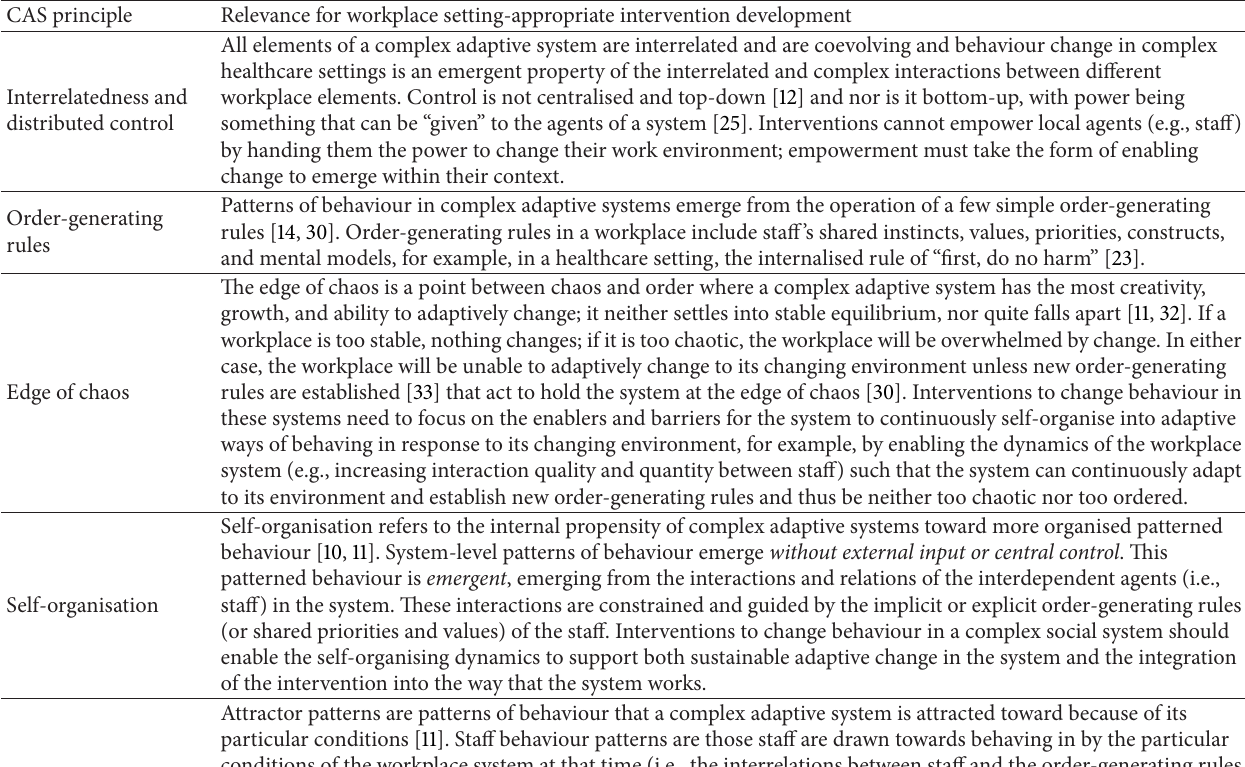
Table 1: The principles of complex adaptive systems (CAS) and how each principle is relevant to developing setting-appropriate interventions in workplace